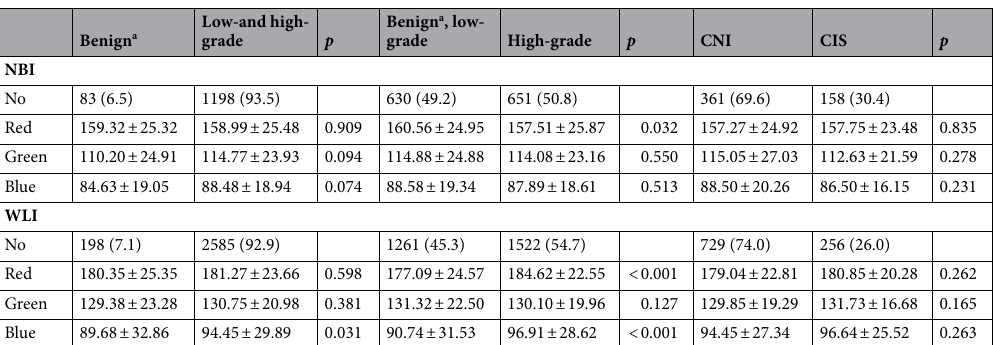
Table 2. Baseline RGB characteristics in the NBI and WLI groups. Data are expressed as number (%), mean ± standard deviation. CIS carcinoma in situ, CNI chronic non-specific inflammation, NBI narrow-band image, RGB red/green/blue, WLI white-light image. a Benign defined cystitis cystica or cystitis grandularis except CNI.